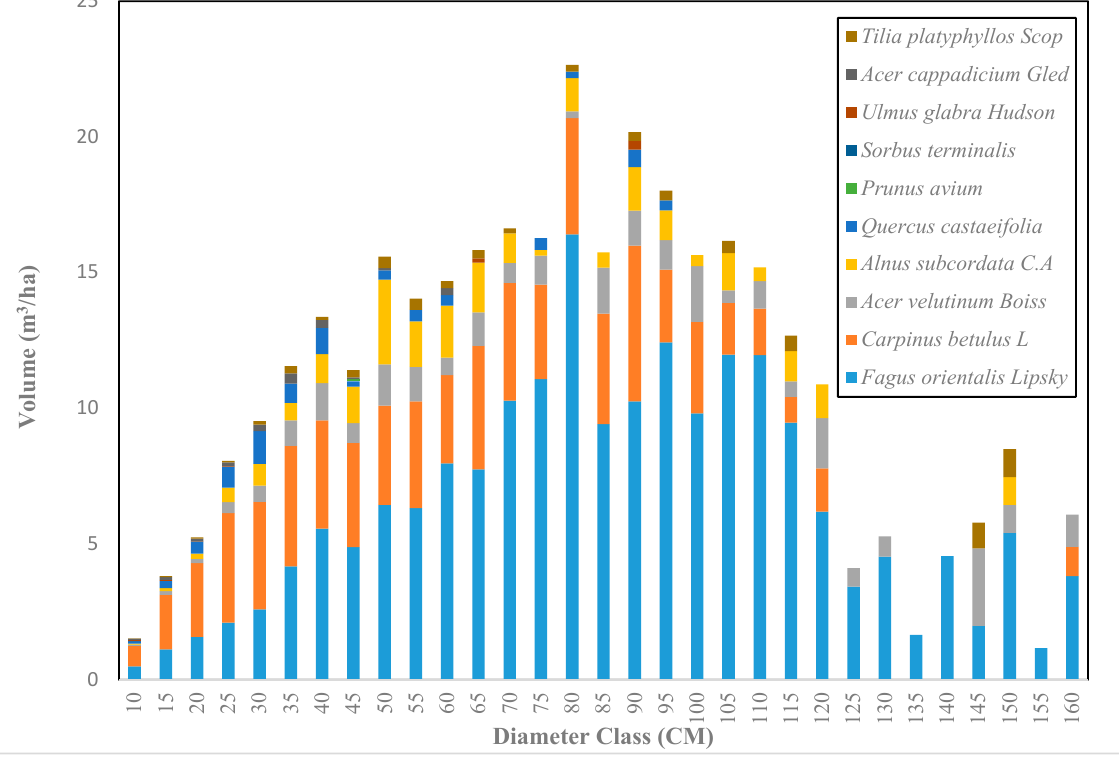
Figure 7. The volume distribution based on diameter class in the Gorazbon section in 2012.